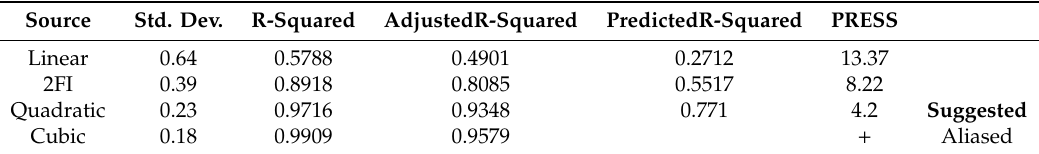
Table 5. Model summary statistic for HDR.